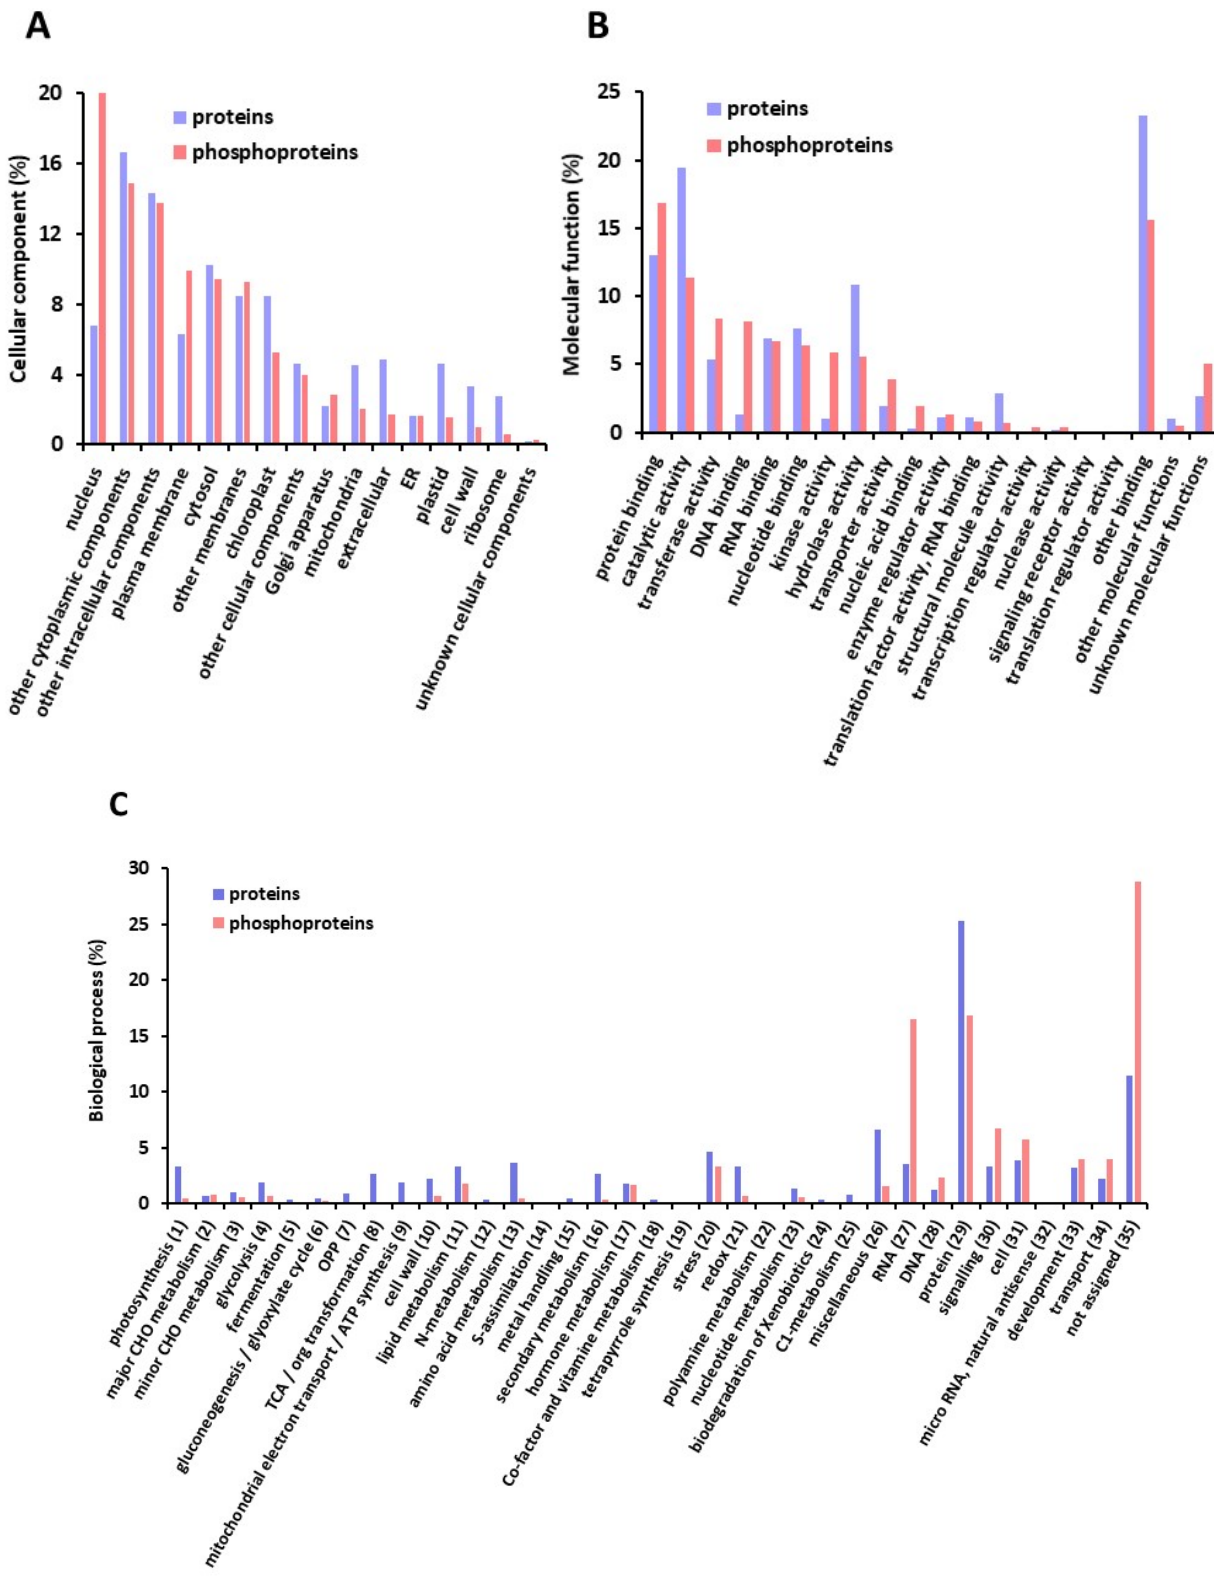
Figure 5. Functional classification of seed proteins and phosphoproteins. ( A ) cellular localization (according to TAIR GO classification). ( B ) molecular function (according to TAIR GO classification). ( C ) biological processes (according to MAPMAN using BAR interface).